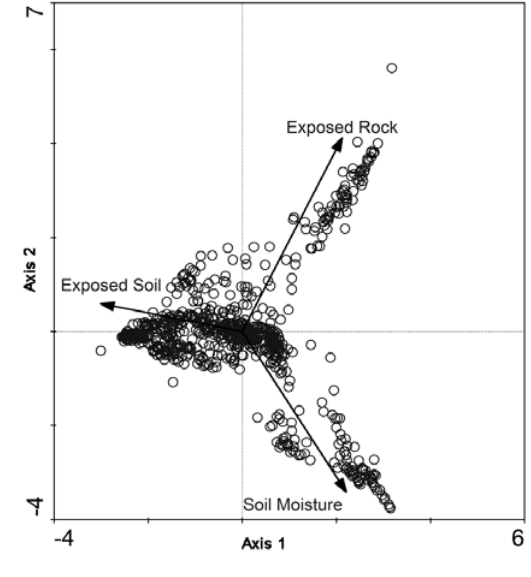
Figure 2. The CA biplot of the combined dataset of CB and SL with the first and second ordination axes and supplementary environmental variables overlain to aid in interpretation (soil moisture, exposed rock, exposed